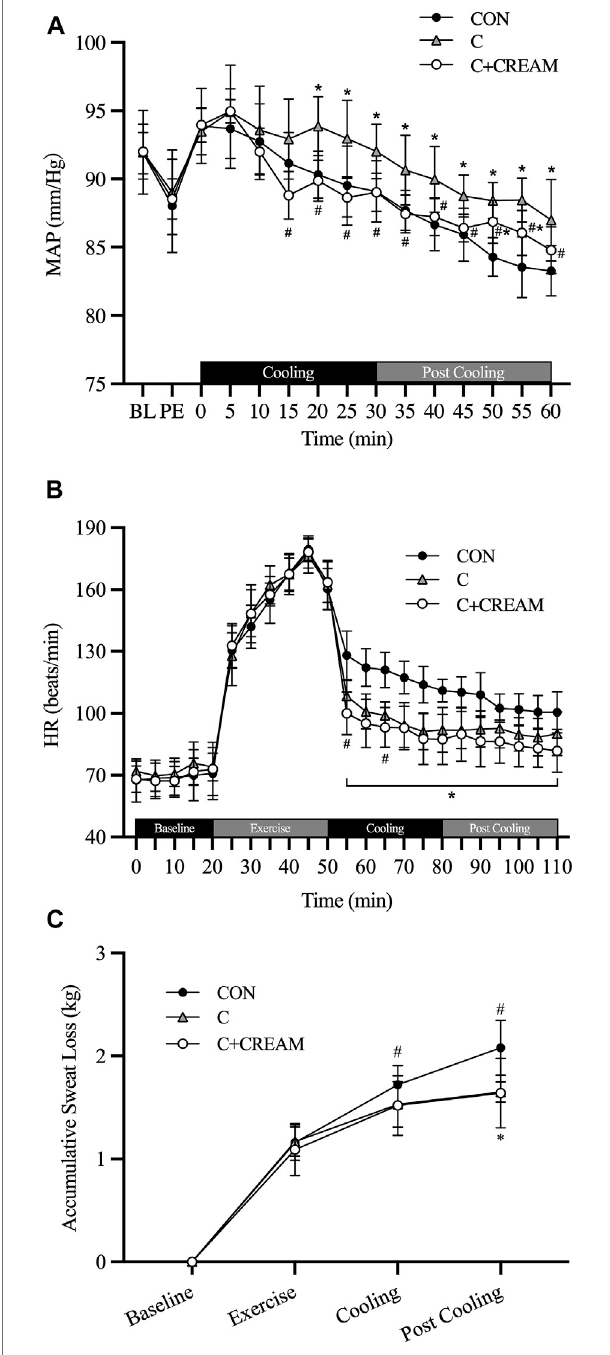
FIGURE 5 | Mean arterial pressure (MAP), heart rate (HR), and accumulative sweat loss. Changes in MAP (A) during cooling and post cooling, HR (B) and accumulative sweat loss (C) during baseline, exercise, cooling, and post cooling are presented. BL, baseline; PE, post exercise; CON, control cooling; C, ice-suit cooling; C + CREAM, ice-suit cooling with cutaneous application of analgesic cream. Two-way repeated measures ANOVA with a Tukey ’ s post-hoc test for all. Data are presented as the mean ± SD ( n = 10). * p < 0.05 vs. CON. # p < 0.05 vs.